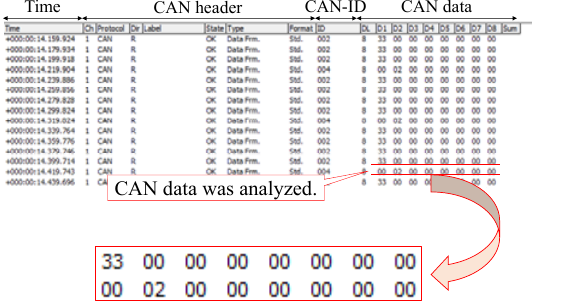
Fig. 7. Observed data (Normal CAN communications)